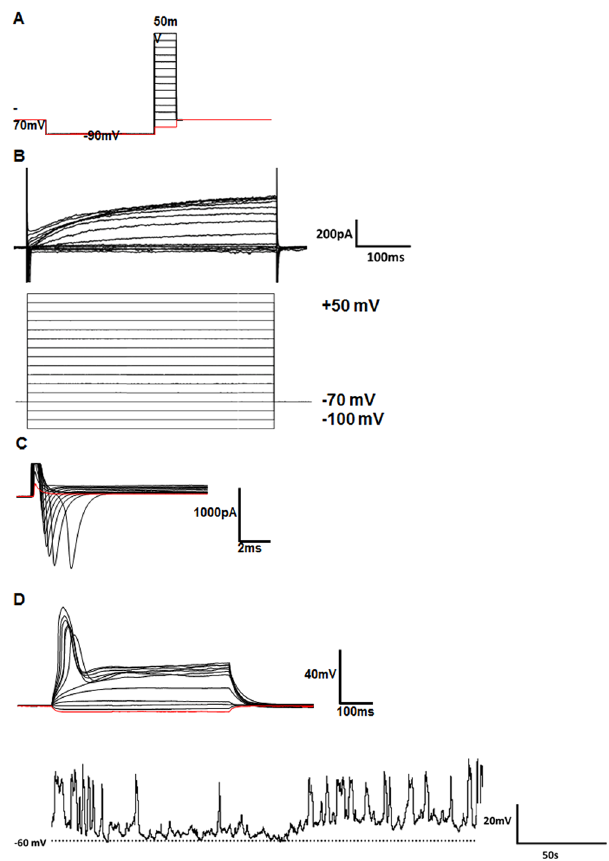
Figure 5. Electrophysiological evidence for successful neuronal development. ( A ) Whole-cell voltage clamp recording protocol used for patch-clamp analysis. ( B ) Representative example for K + currents observed during 500 ms voltage steps of the whole-cell voltage clamp recording protocol displayed in ( A ). ( C ) Representative example of Na + currents observed during 20-ms voltage steps of the whole-cell voltage clamp recording protocol displayed in ( A ). Note that Na + currents (downward deflections) were observed at voltages ≤− 30 mV. ( D ) Individual traces of action potential-like events generated by an intracellular current injection protocol. Spontaneous action potential-like events were recorded in current-clamp mode (0 pA). The dashed line indicates the − 60 mV resting membrane